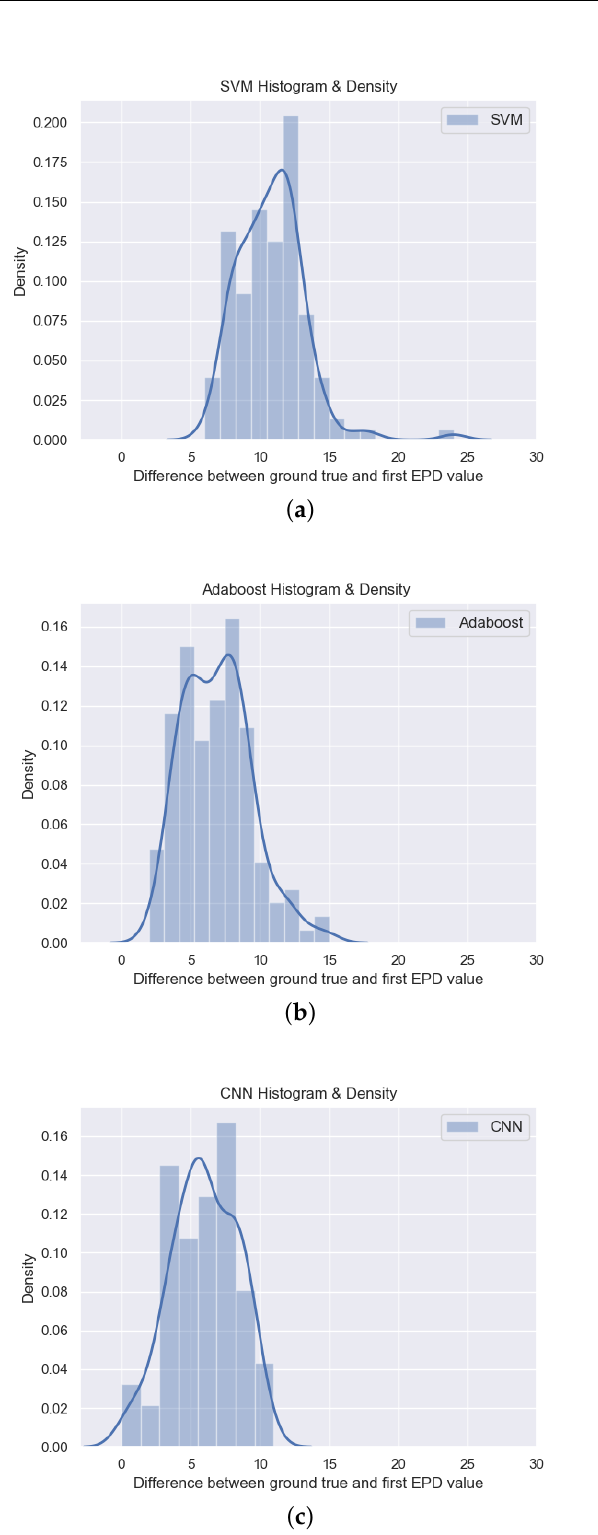
Figure 10. Histograms of the differences between the ground truth and the model output for the three models ( a ) SVM ( b ) Adaboost ( c )